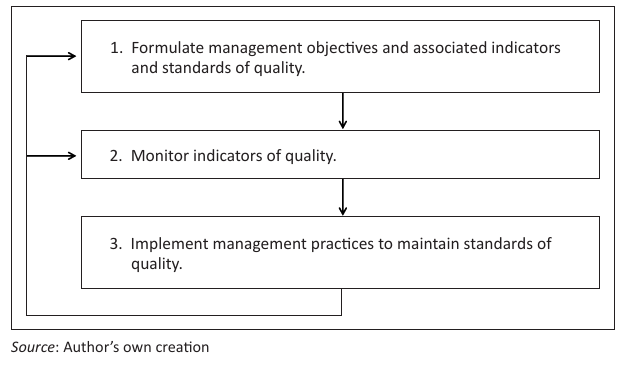
FIGURE 1: A framework for managing outdoor recreation and tourism in parks and protected